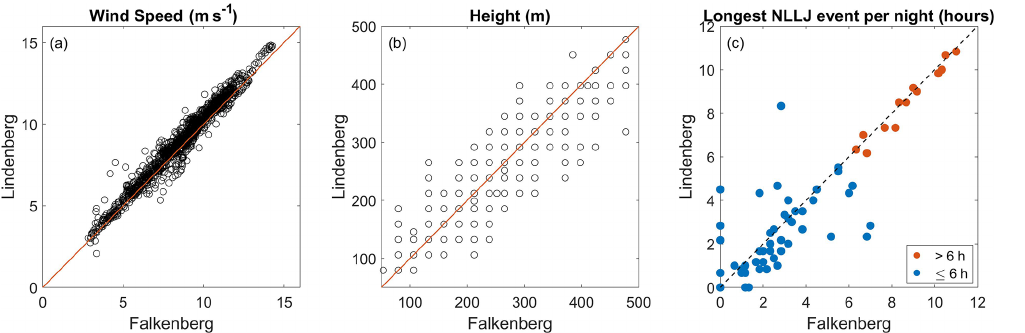
Figure 10. Characteristics of co-occurring NLLJs at the two sites. Shown are (a) core wind speed, (b) core height and (c) lifetime of the longest NLLJs per night. In (c) , events longer than 6h at both sites are shown in red.